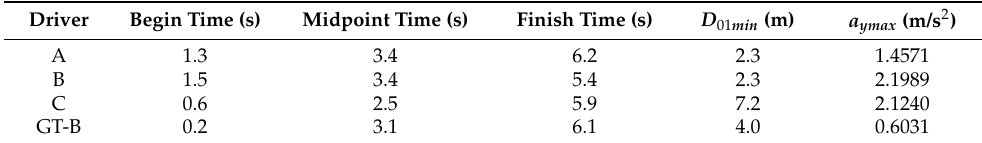
Table 8. Driving parameters of different drivers under Case Ⅱ.